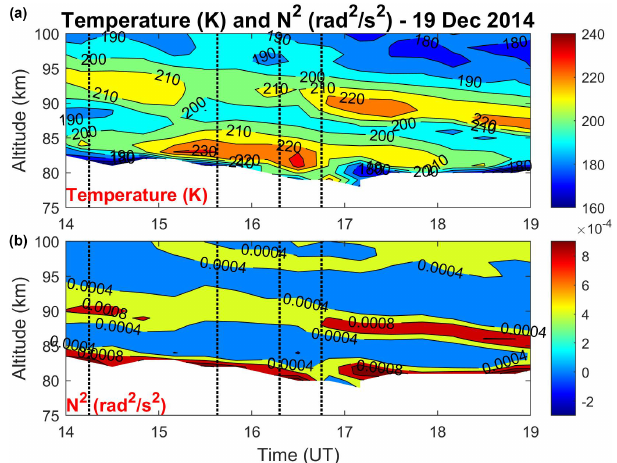
Figure 9. Vertical shears of the horizontal wind: (a) zonal and (b) meridional. The dotted black lines indicate the estimated times of zenith passage of the